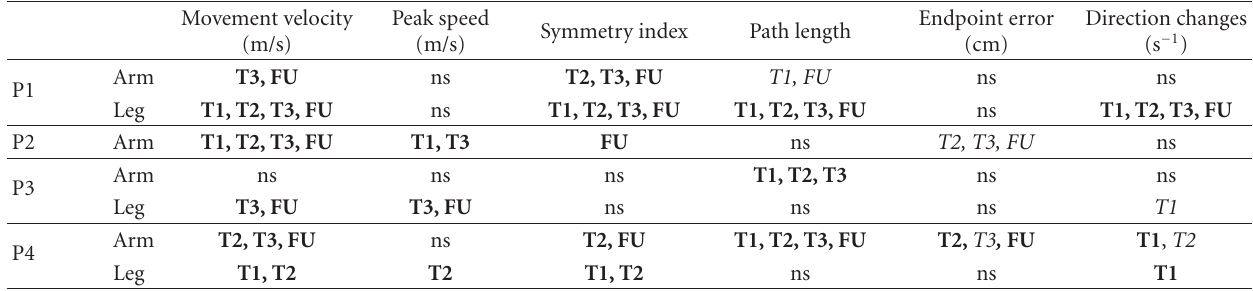
Table 3: Significant performance changes compared to baseline (BL). Significant improvements of motor performance in bold, deterioration of performance in italic, ns: not significant. BL: mean of B1 and B2, baseline tests before training. T1, T2, T3: tests during and at the end of the training period. FU: follow-up test after